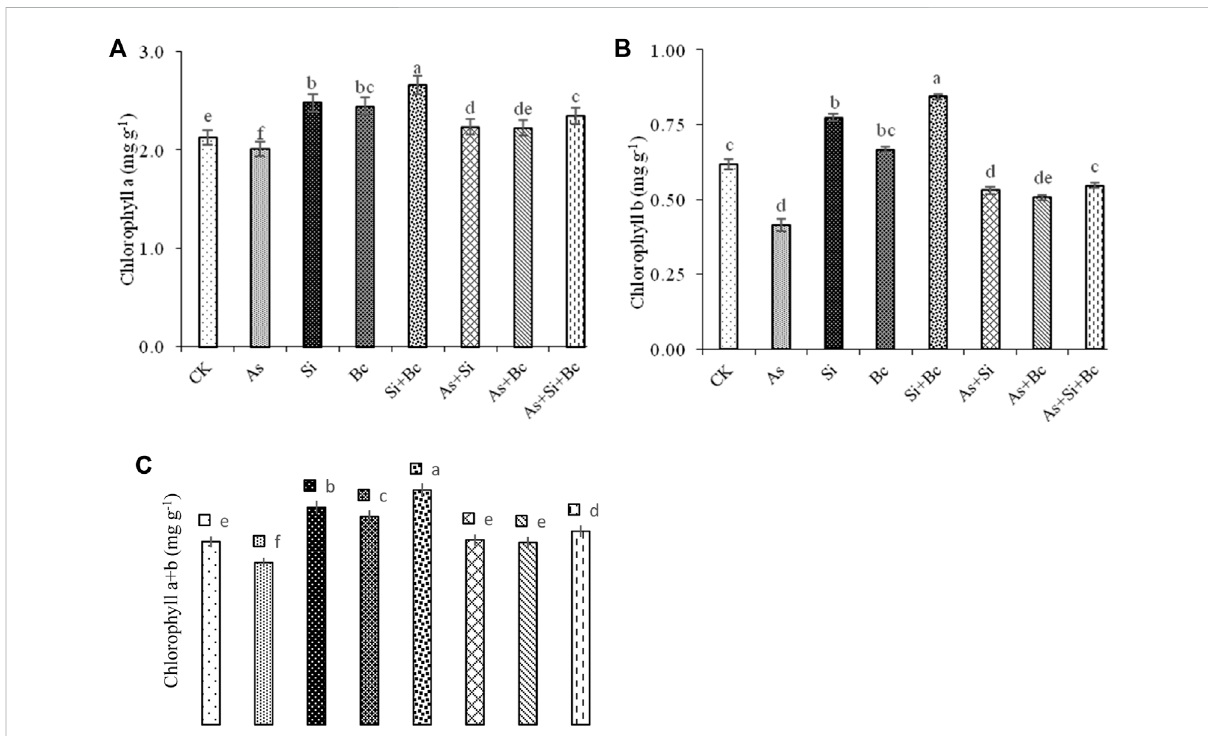
FIGURE 1 Effect of sole and combined applications of silicon and biochar on chlorophyll a (A) , chlorophyll b (B) , and chlorophyll a + b (C) of maize under As toxicity. Bars sharing the same letter do not have a signi fi cant ( p < 0.05) difference. Error bars show the standard error of mean.